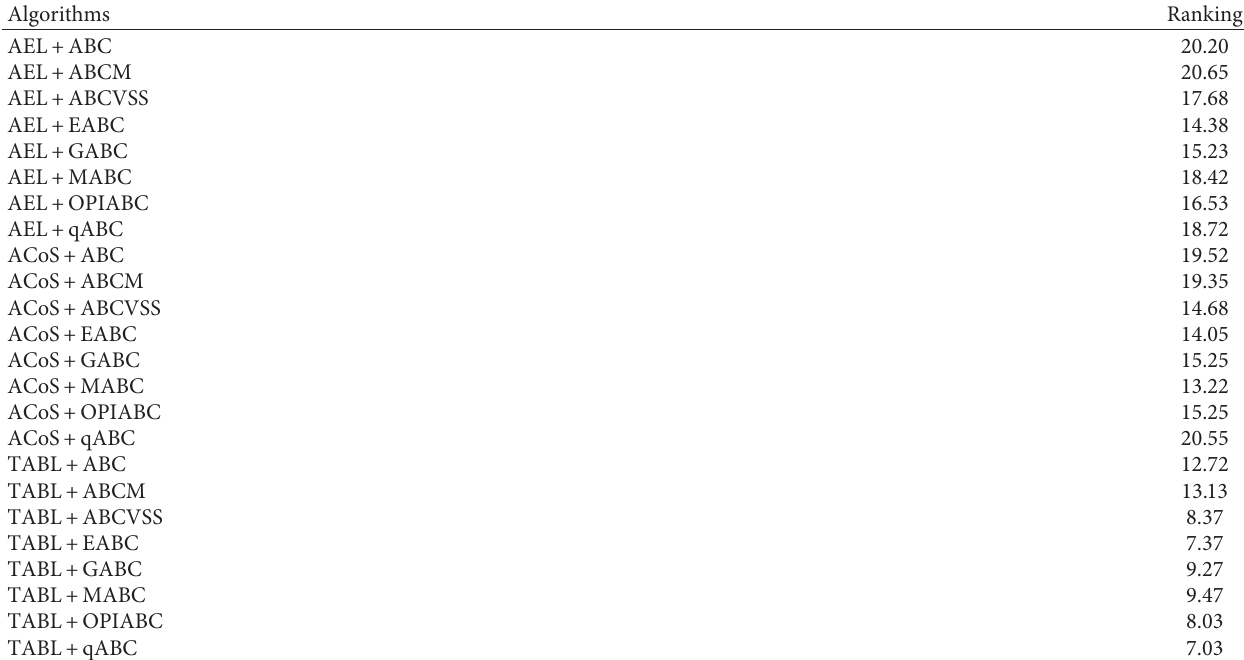
Table 8: The average ranking of twenty-four algorithms based on the Friedman test, respectively.